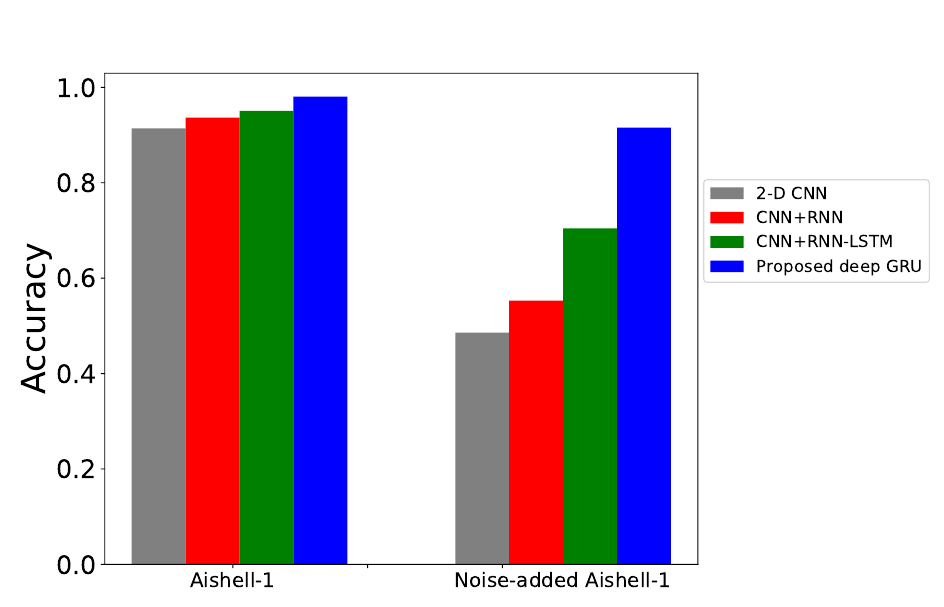
Figure 10. Performance comparison of proposed deep GRU network model with other network models. The block on the left side shows the performance of the models on the original Aishell-1 dataset, and the right part corresponds to the performance on the Aishell-1 dataset with Gaussian white noise.